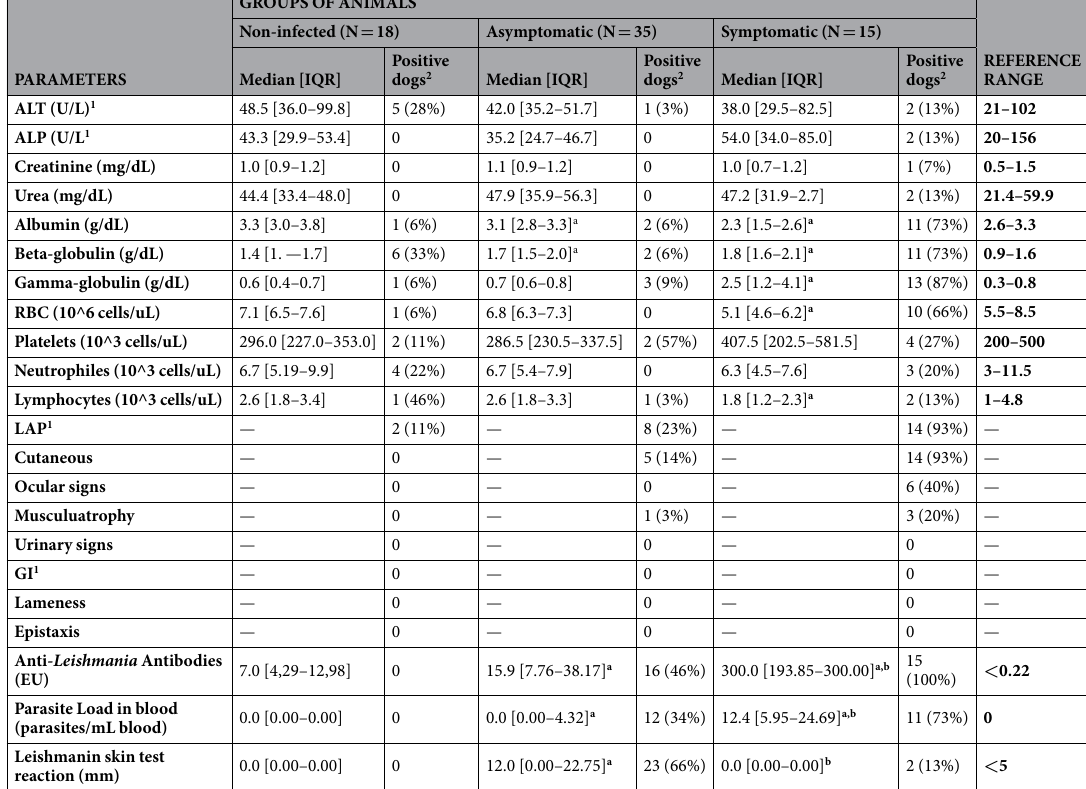
Table 1. Baseline characteristics of the dog population used in the current study. a = Statistically different from non-infected dogs ( P < 0.05); b = Statistically different from asymptomatic dogs ( P < 0.05). 1 ALT: Alanin-amino tranferase; ALP: Alkaline phosphatase; LAP: Lymphadenopathy; GI: Gastrointestinal signs. 2 Number of dogs from each group that showed a value out of the reference range for each one of the parameters under evaluation.